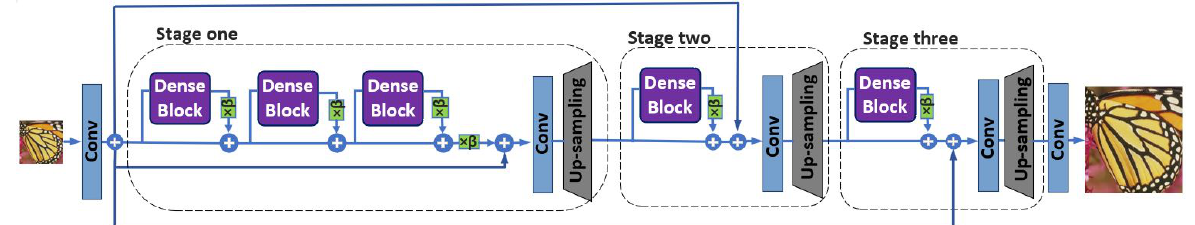
Figure 2. Network architecture with progressive upsampling